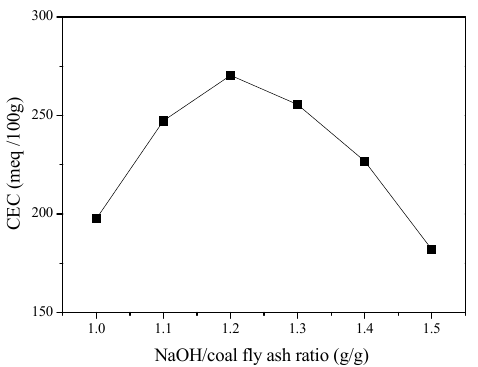
Figure 1. Effect of NaOH/coal fly ash ratio on the cation exchange capacity (CEC) of synthesized zeolite (liquid/solid ratio 5 mL/g, 1.5 h alkali fusion under 550 °C, 15 h hydrothermal treatments under 90 °C).